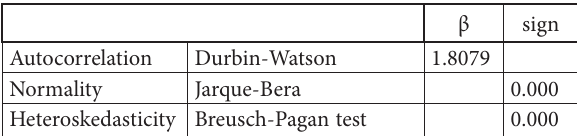
Table 3. Test of multicollinearity, heteroskedasticity, non normality and spatial dependence in